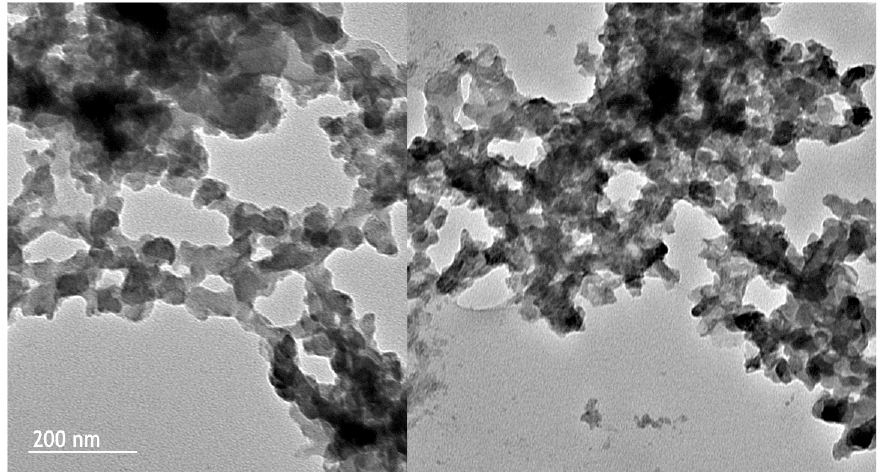
Figure 6. TEM microscope images of nanocellulose isolated from banana pseudo-stems.